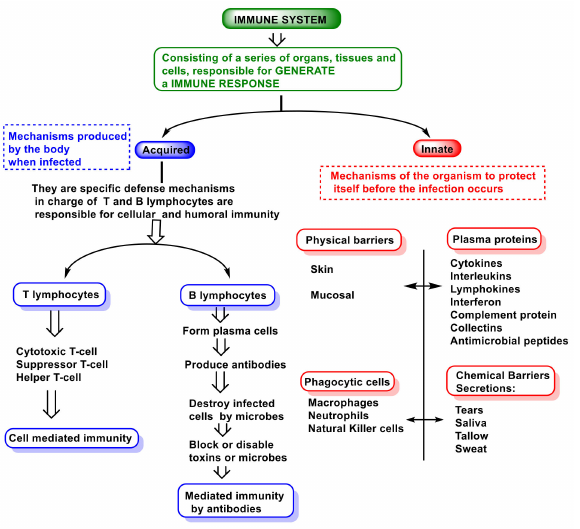
Figure 2. Innate and adaptive immune